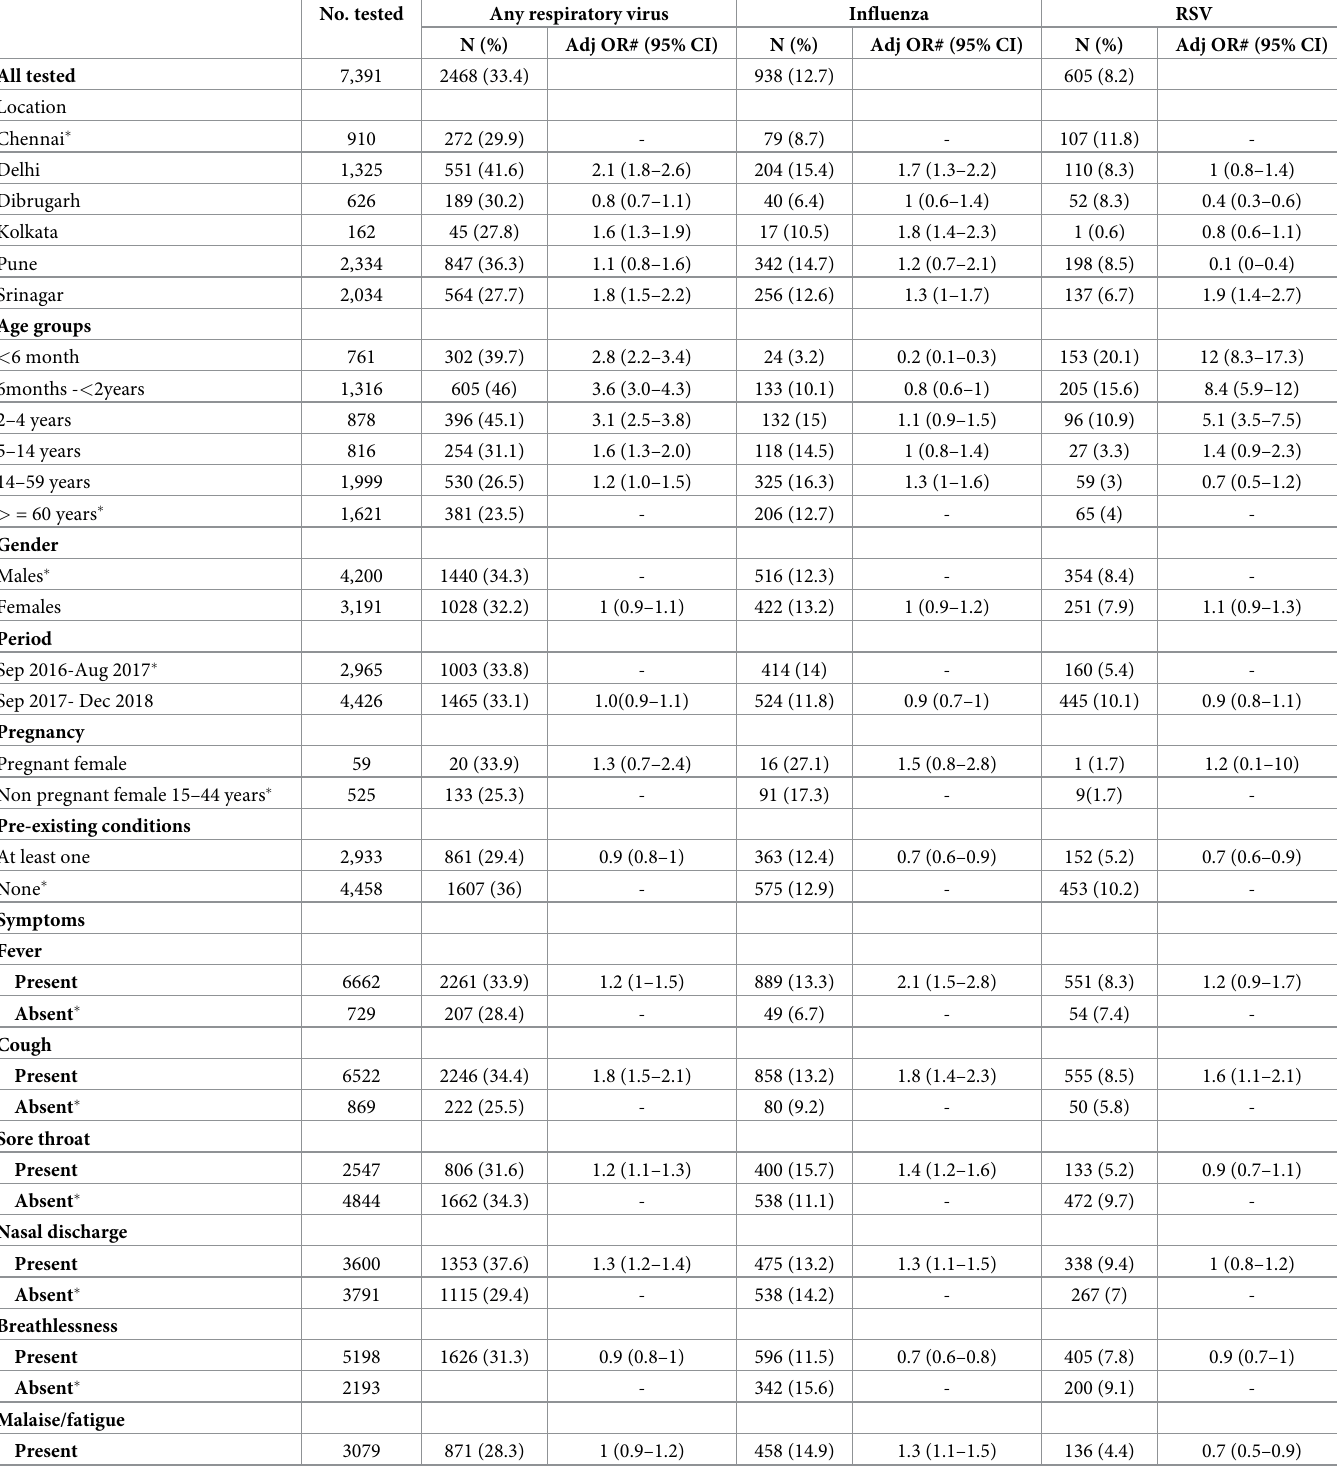
Table 2. Percent positive of respiratory viruses by clinical-epidemiological characteristic among hospitalized patients with severe acute respiratory infection, India